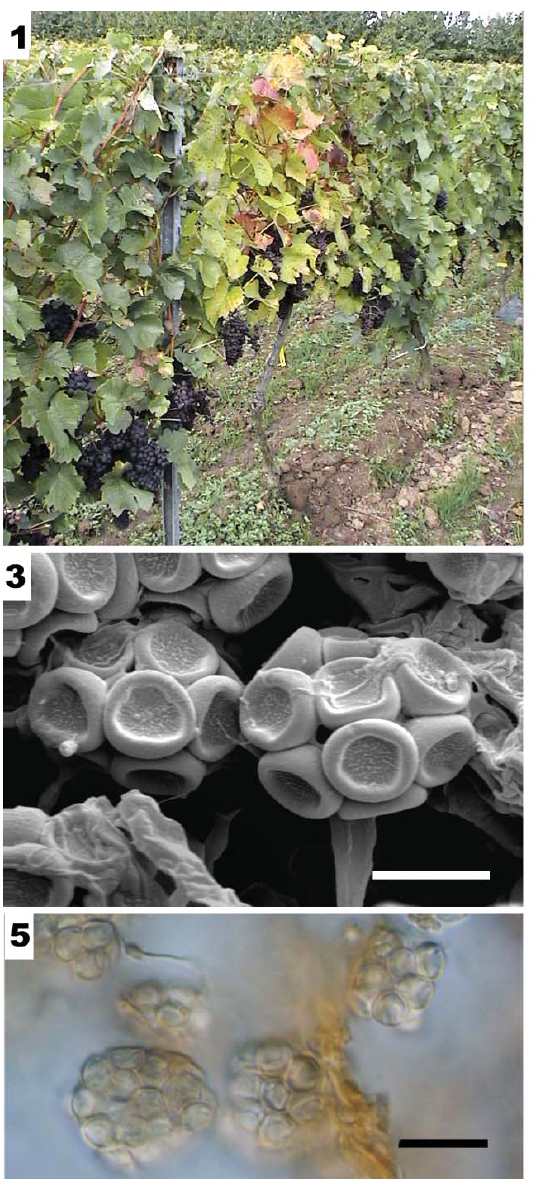
Fig. 1–6. Sorosphaera viticola Kirchm., Neuh. & L. Huber. 1. Infested vine exhibiting a precocious reddening. In the insert, arrows mark the infested parts of an excavated rootstock. 2–3. Scanning electron micrographs of sporosori (aggregated resting spores). Bar=100 μ